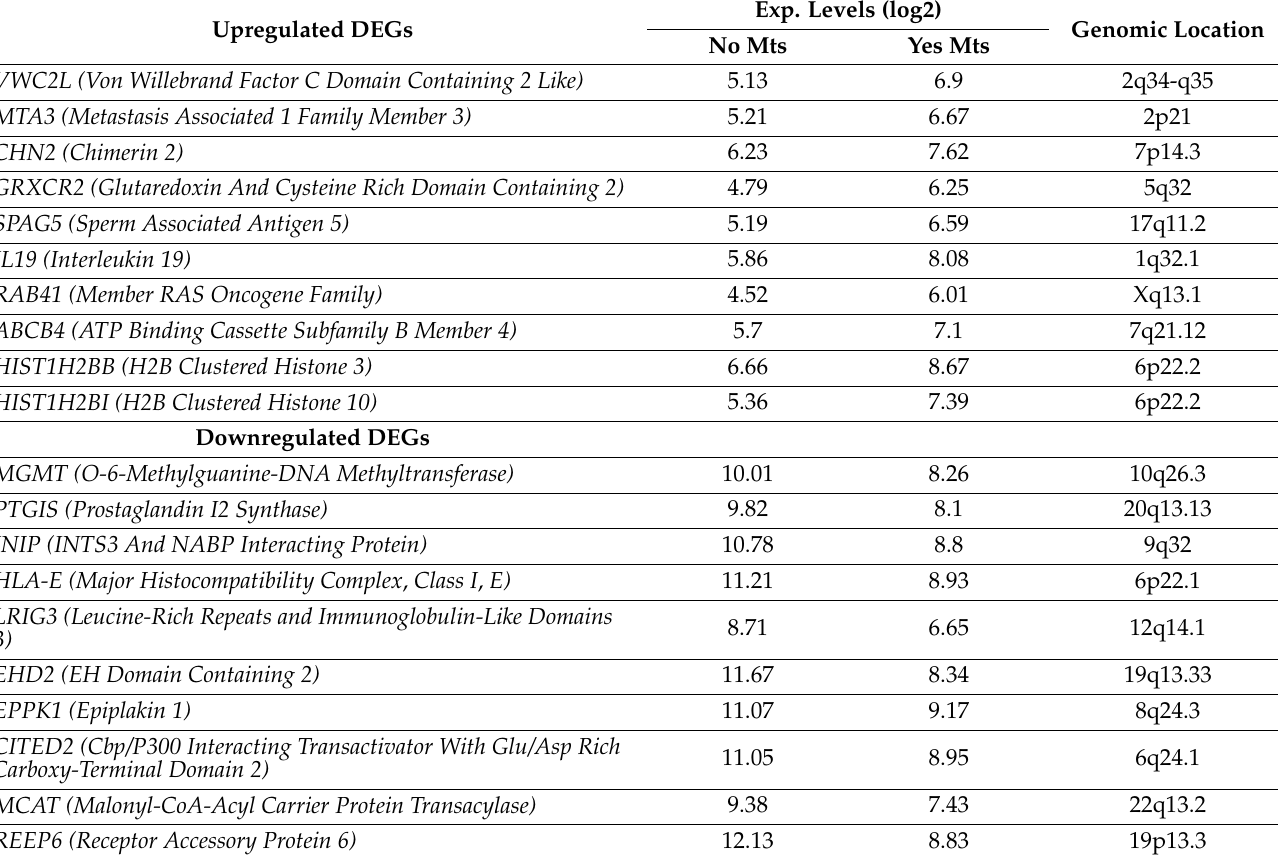
Table 2. Top-10 upregulated and downregulated DEGs in the tumor BC patients before and after NAC chemotherapy, depending on the absence/presence of hematogenous